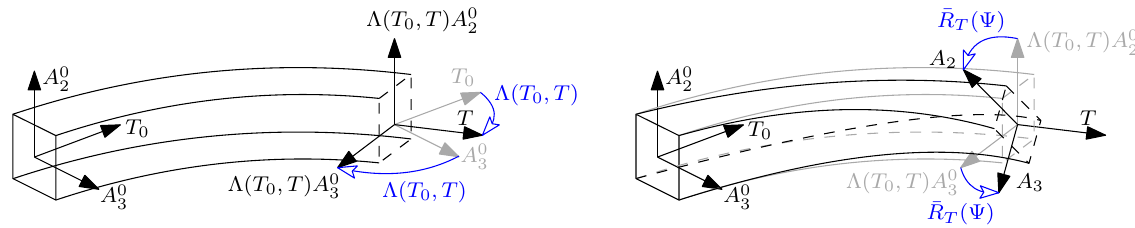
¯R Figure 3. The Λ ( T 0 , T ) and T (Ψ) operations used for the alignment of the cross-section at the current position. for the alignment of a moving trihedral illustrated in Figure 3. While the mapping matrix Λ ( T 0 , T ) aligns the reference trihedral given by the tangent T 0 to the tangent T at the current position, the rotation matrix ¯R T (Ψ) rotates the aligned reference trihedral about T with given rotation Ψ. The rotation Ψ = Ψ( θ 1 ) is calculated using basis functions and values ˆΨ i assigned to the control points. The Euler-Rodriguez formula [5] is used to define both the mapping matrix Λ and the rotation matrix R T